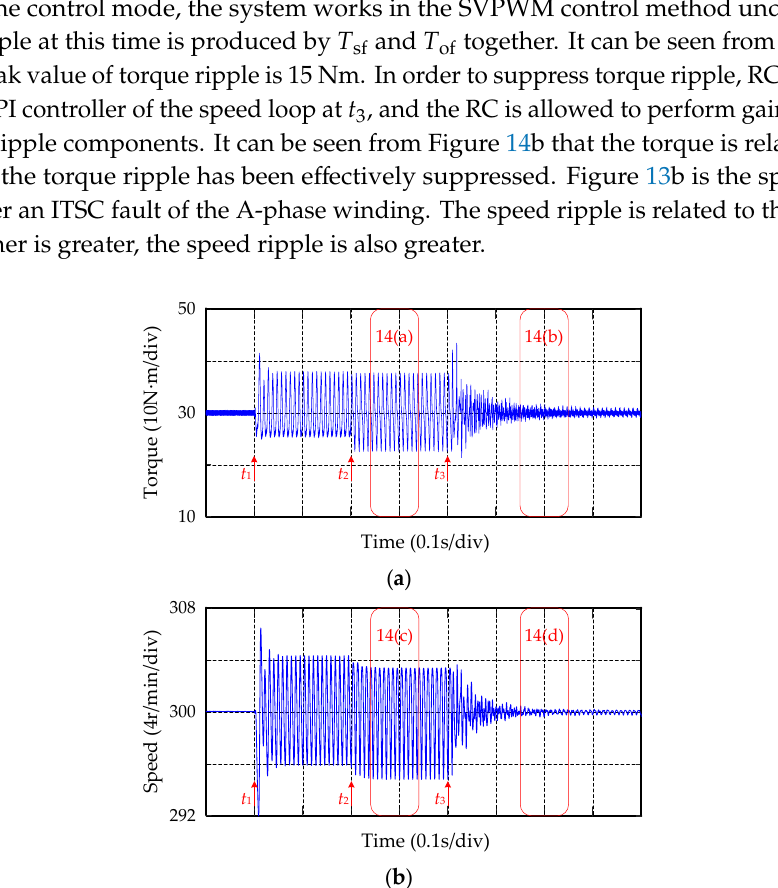
Figure 13. Torque and speed waveforms of five-phase PMSM before and after ITSC fault: ( a ) The output torque under normal, short-circuit, and fault-tolerant conditions; ( b ) The speed under normal, short-circuit, and fault-tolerant conditions.